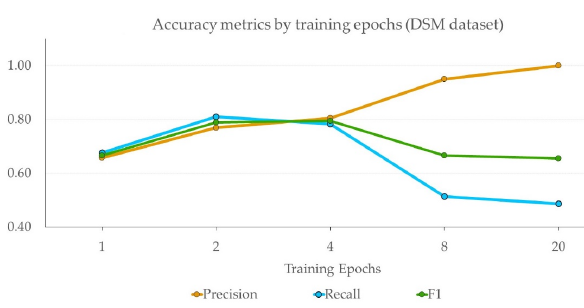
Figure 5. Accuracy metrics for the cross-validation dataset by number of fine-tuning epochs. Adapted from Gallwey et al. (2019)